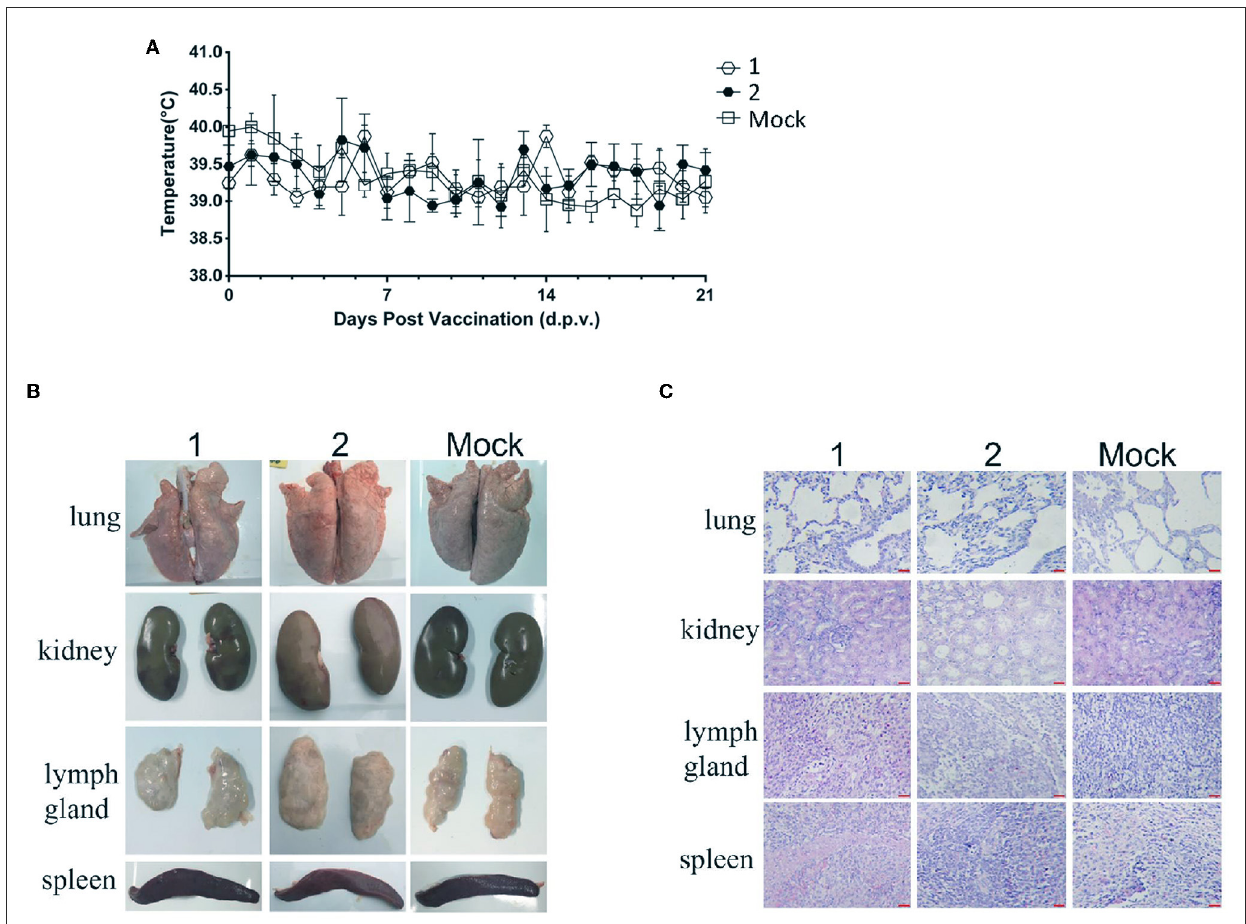
FIGURE3 Safety comparison test between in vivo passage serum mixture inoculated group and original virus inoculated group. The changes in rectal temperature of pigs in each group after inoculation, autopsy results, and histopathological observation. (A) Daily rectal temperature record of rPRRSV-E2 inoculation group compared with in vivo passage sera inoculation group. (B) Gross pathological changes of organs and tissues (spleen, lung, kidney, and lymph node) of rPRRSV-E2 inoculation group (1) and in vivo passage mixed-sera inoculation group (2) after necropsy. (C) Histopathological observation of organs and tissues (spleen, lung, kidney, and lymph node) of rPRRSV-E2 inoculation group (1) and in vivo passage mixed sera inoculation group (2) after necropsy. Scale bar = 200 µ